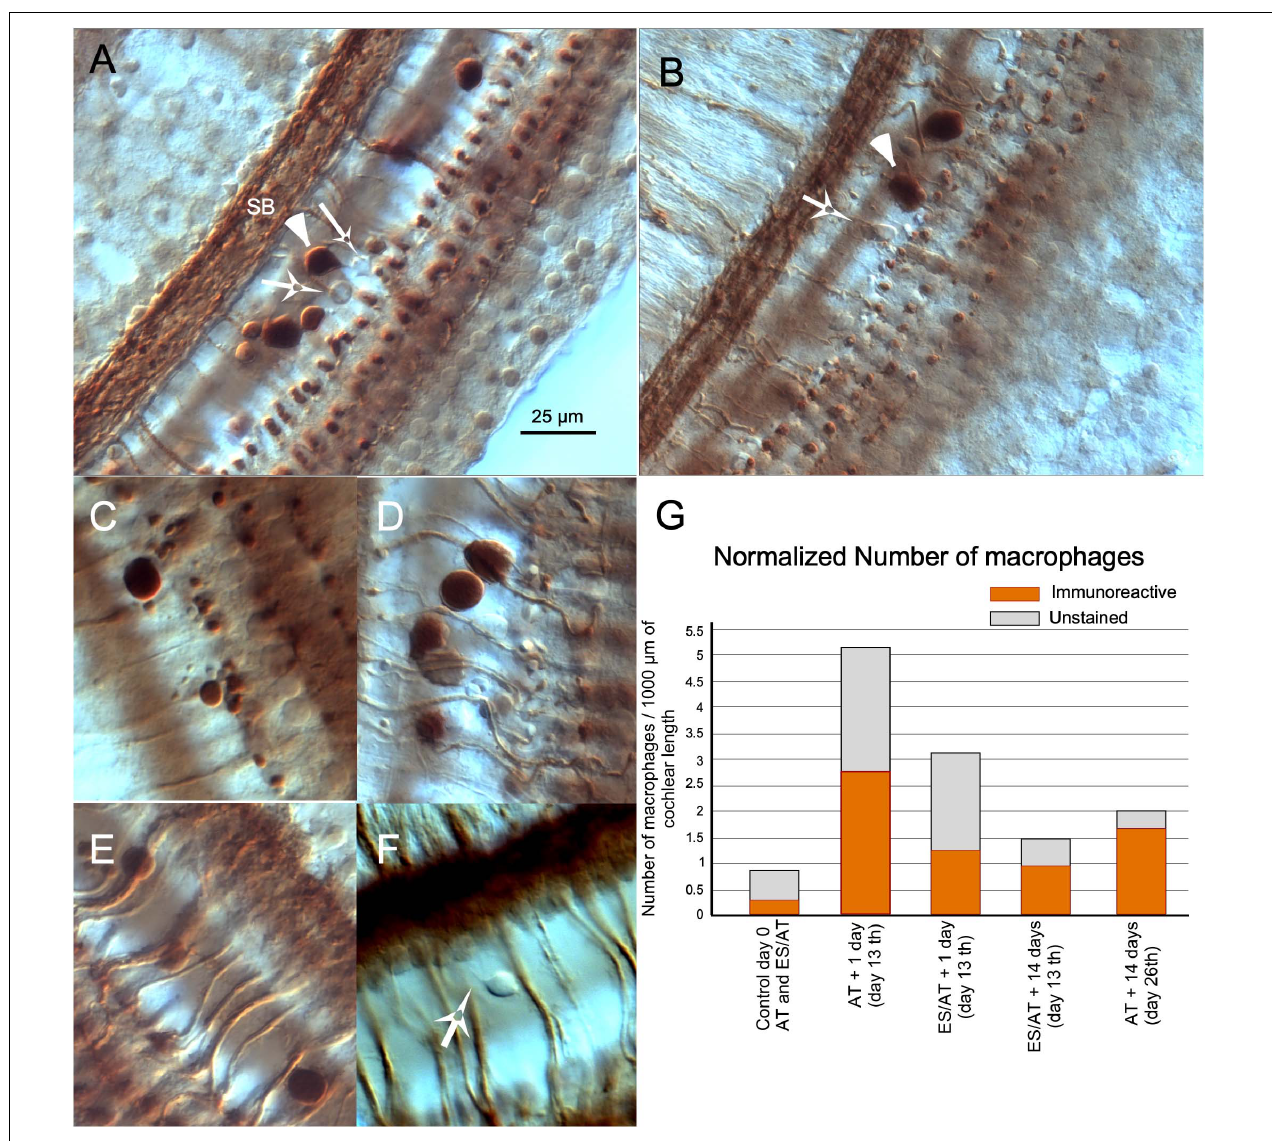
FIGURE 6 | Inflammatory reaction in the cochlea after acoustic trauma. (A) Panoramic view of the organ of Corti in surface preparation. Large immunoreactive inflammatory cells (arrowheads) are interspersed with other smaller non-immunoreactive (arrows). (B) Inflammatory cells, presumably macrophages, migrating to the OHC area. (C,D) Details of close contacts of immune cells with immunoreactive terminals. Cell debris is associated with the loss of terminals. (E) Immune cells climbing along efferent fibers. (F) Presumably monocytes with filopodia, most frequently observed in the floor of the tunnel. Differential interference contrast microscopy (Nomarski) ( × 63 PLAN APO Leica/NA 1.32-0.6 immersion oil). (G) Quantification of the immune response by counting separately the number of immunoreactive and unstained macrophages. The number of inflammatory cells is higher after AT in the AT group and decreases at 14 days (day 26th). SB spiral